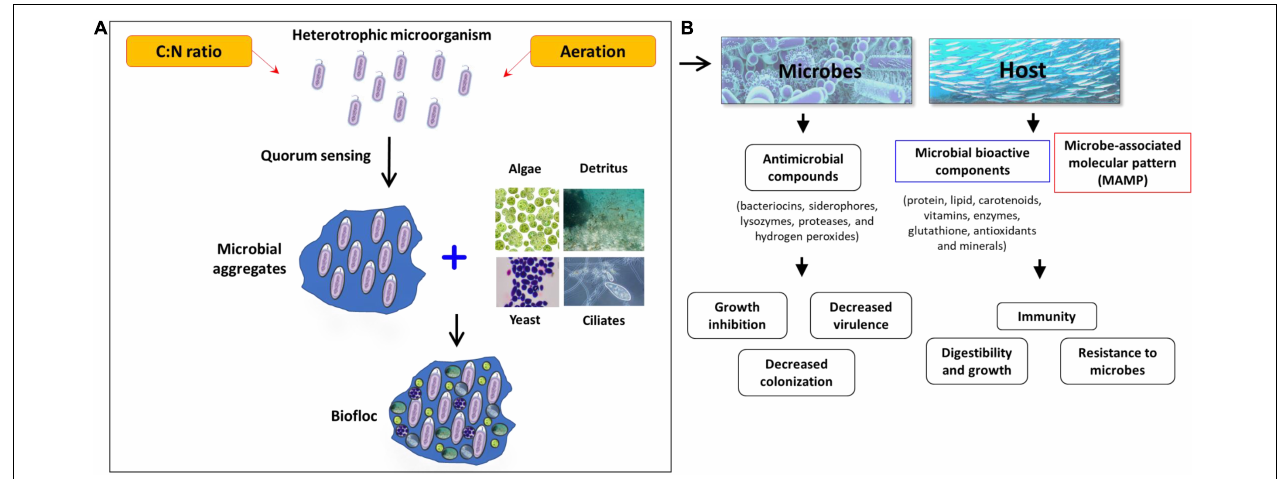
FIGURE 3 | Schematic overview on the possible role of the biofloc microbiome. (A) Development of a biofloc system; (B) potential role of the biofloc system against pathogenic microbes and in a